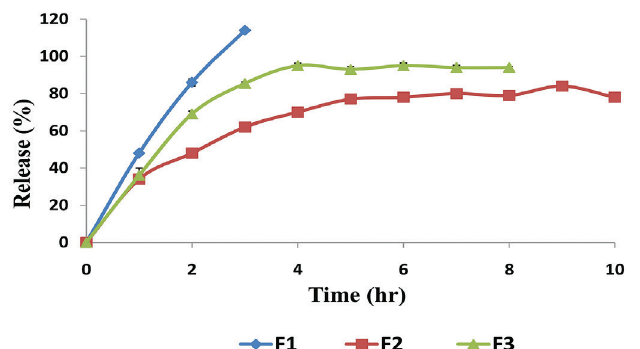
FIGURE 8 - Effect of the crosslinking time on the FLB release from chitosan microspheres in PBS: F2: 30 min. (2% TPP); F4: 60 min. (2% TPP) and F5: 120 min. (2%